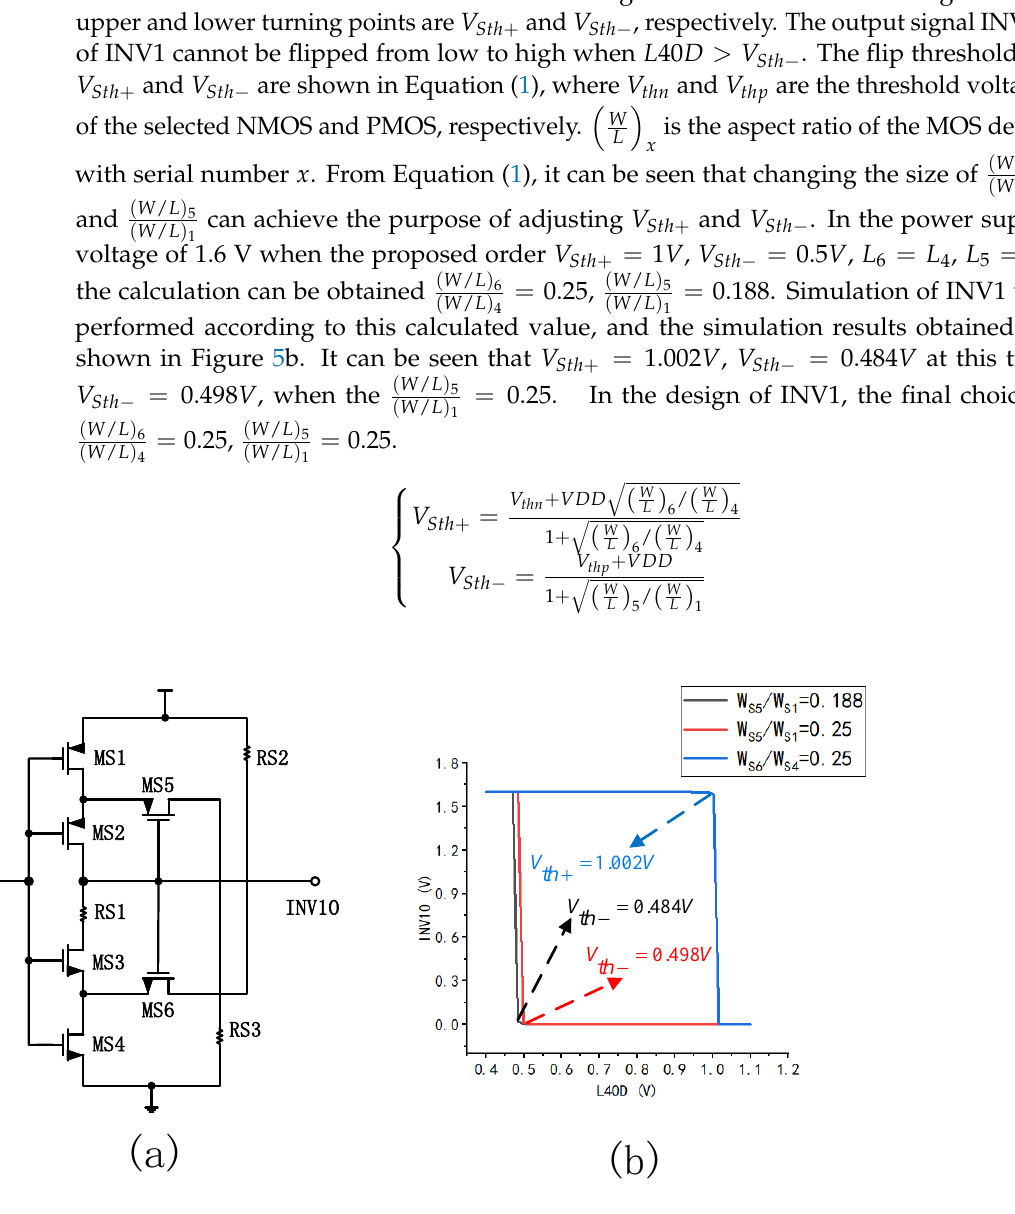
Figure 5. INV1 circuit structure and flip threshold simulation results. ( a ) INV1 circuit structure. ( b ) Flip threshold simulation